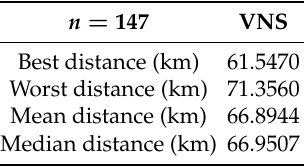
Table 4. Results of 10 executions n = 147 problem,